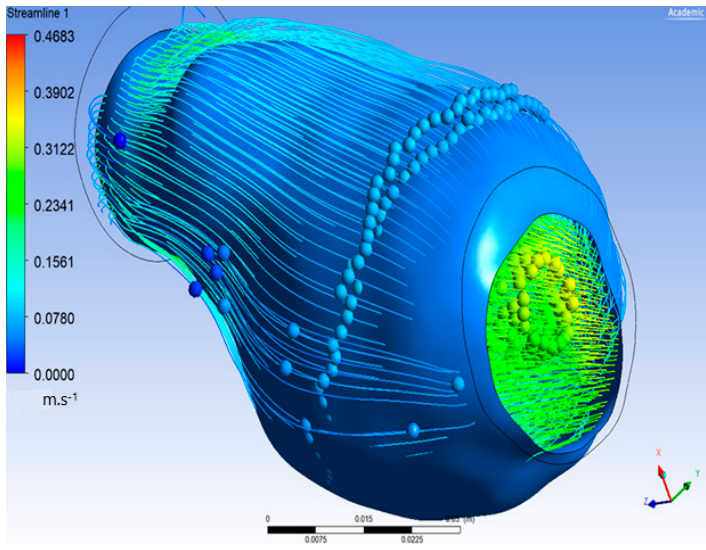
Figure 8. Particle flow inside aneurysm.